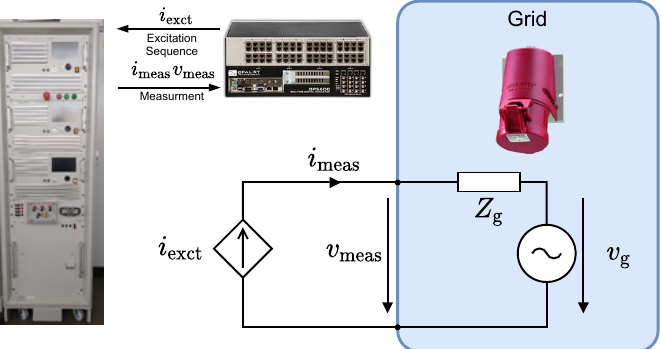
Figure 23. Measurement setup for the industrial power grid impedance identification.